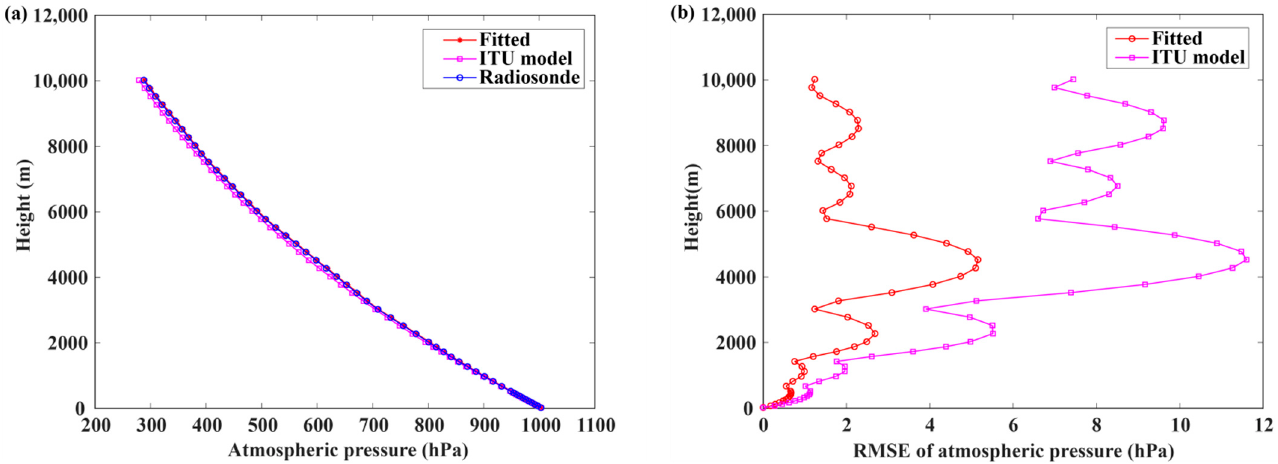
Figure 8. ( a ) The comparison between fitted, ITU model, and radiosonde atmospheric pressure profile; ( b ) The RMSE of fitted and ITU model atmospheric pressure profile.